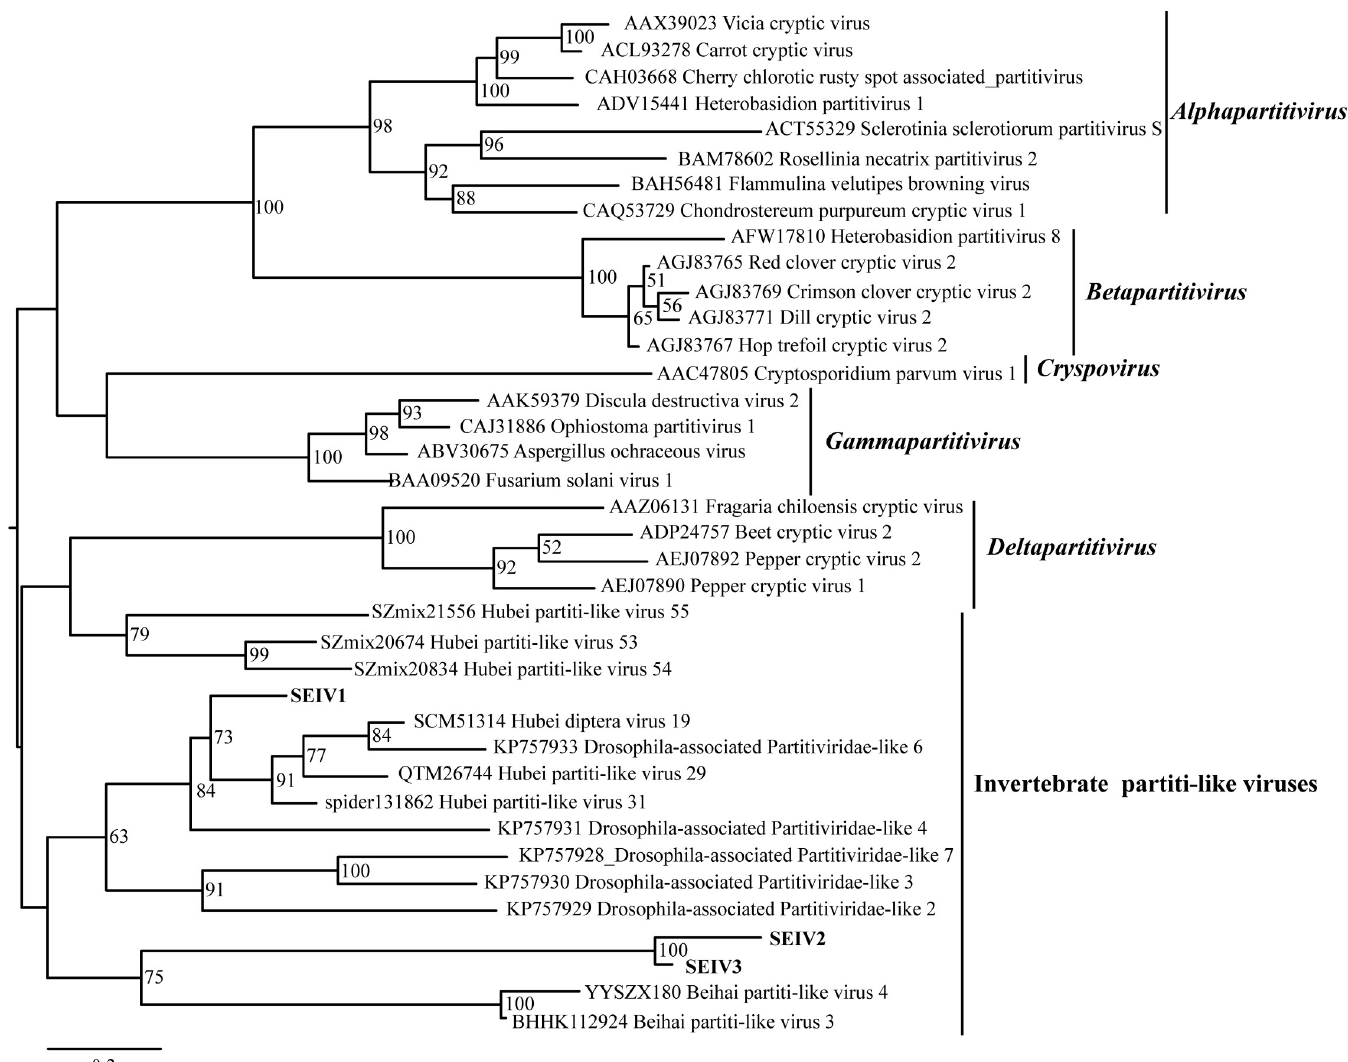
Fig 1. Phylogenetic analysis of partiti-like viruses found in Spodoptera exempta . Maximum likelihood tree constructed with IQ-TREE 1.6.6 using amino acid sequences of the conserved RdRp domain of SEIV1, SEIV2, SEIV3, thirteen other partiti-like viruses from invertebrates, and 22 members from the family Partitiviridae. Alphapartitivirus , Betapartitivirus , Gammapartitivirus , Deltapartitivirus and Cryspovirus are the five genera within the family Partitiviridae , the members of which were reported to infect plant, fungi and protists. The bootstrap values (5000 pseudoreplicates) > 50% are indicated on the nodes.